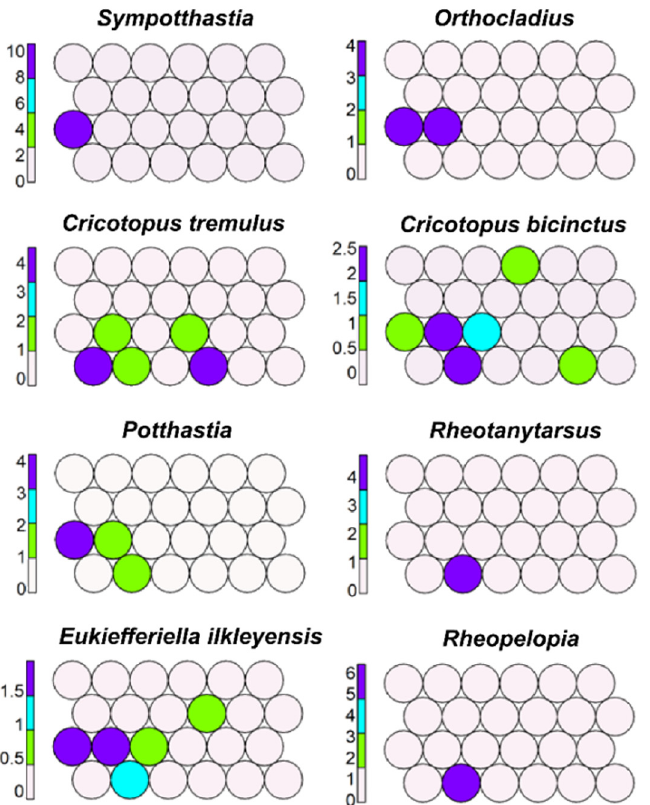
Figure 5. Unsupervised map of another eight morphotaxa characterizing rhithral (lower sector). Taxa associated with aquatic vegetation prevail in cells 4 and 12 (Figure 6) : Pentapedilum sordens , Isocladius sylvestris , Endochironomus , Glyptotendipes , Parachironomus gracilior , and Microtendipes .